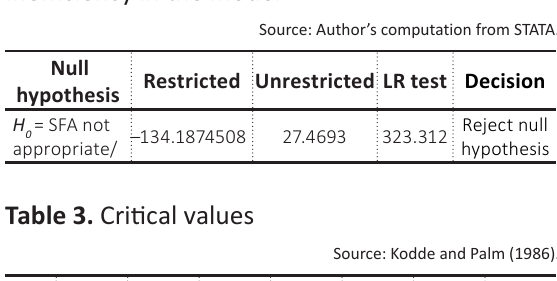
Table 2. Hypothesis testing to ascertain technical inefficiency in the model